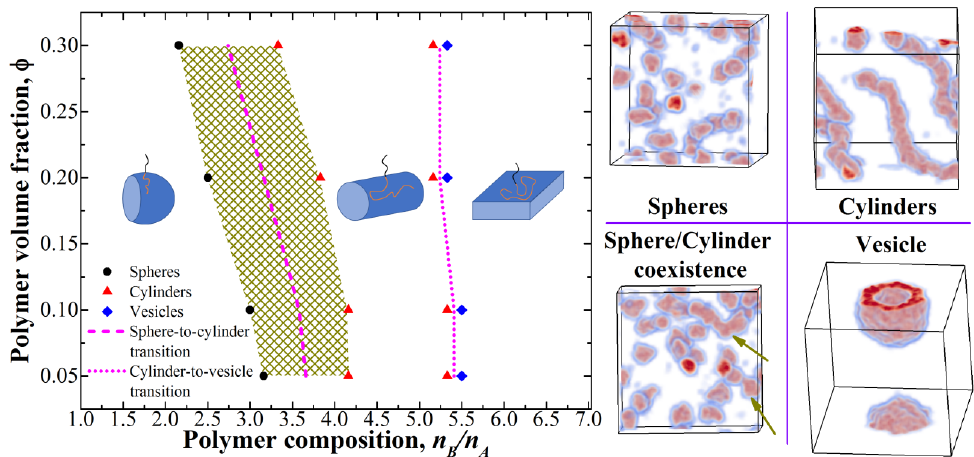
Figure 2. Phase diagram for monodisperse presynthesized diblock-copolymers. Only the points closest to the transitions are shown. The shaded area denotes the transition region between spheres and cylinders; two dark yellow arrows show the “worms” observed in this region in the corresponding